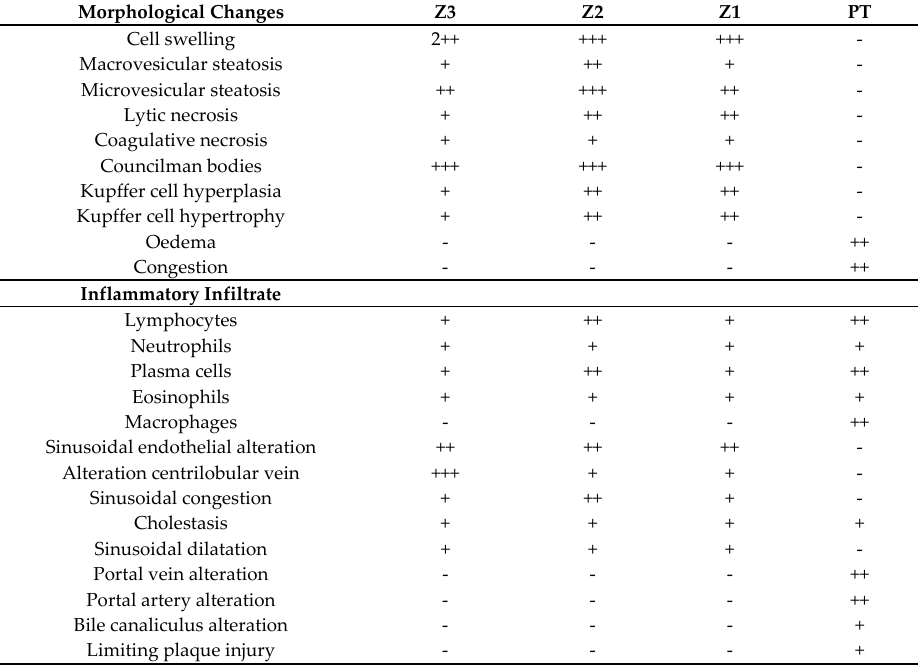
Table 2. Semi ‐ quantitative analysis of morphological changes to the hepatic acinus (Z3, Z2, Z1) and the portal tract (PT) in the liver of 21 patients with fatal YF and 05 normal controls. Morphological